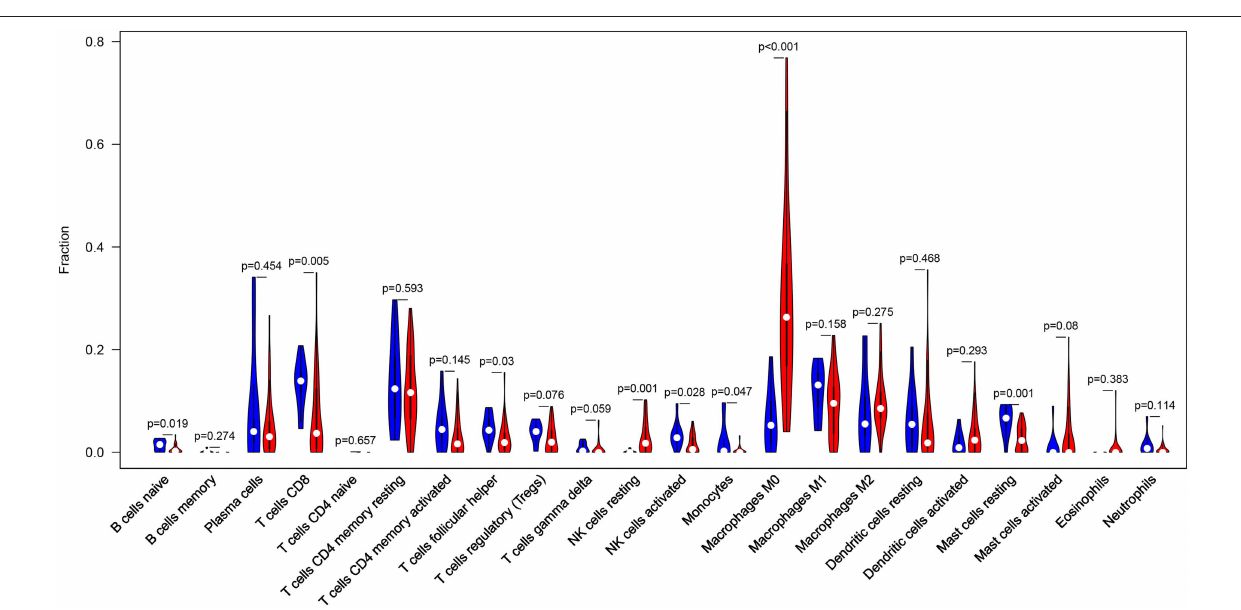
Frontiers in Oncology | www.frontiersin.org